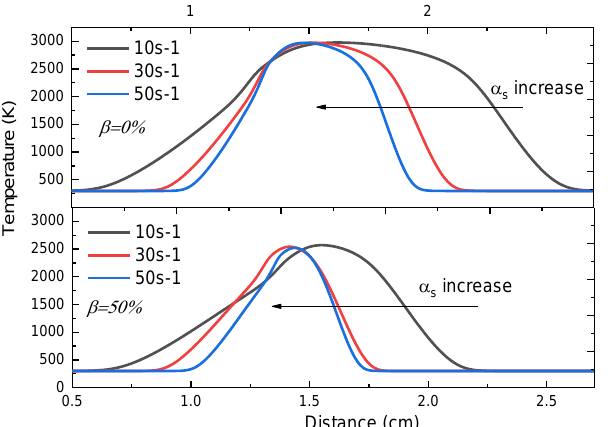
Figure 8. The distribution of the flame temperature with different global strain rates at p = 1 atm and β = 0%, 50%.